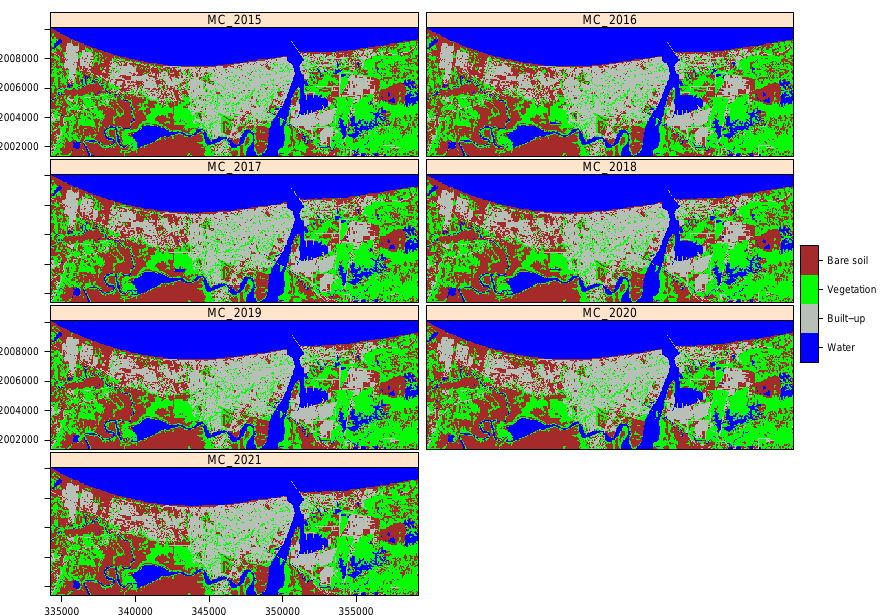
Figure 4. Maps of the macro-class-based classification for the study period (2015-2021). Units: meters. Projection: WGS84 / UTM Zone